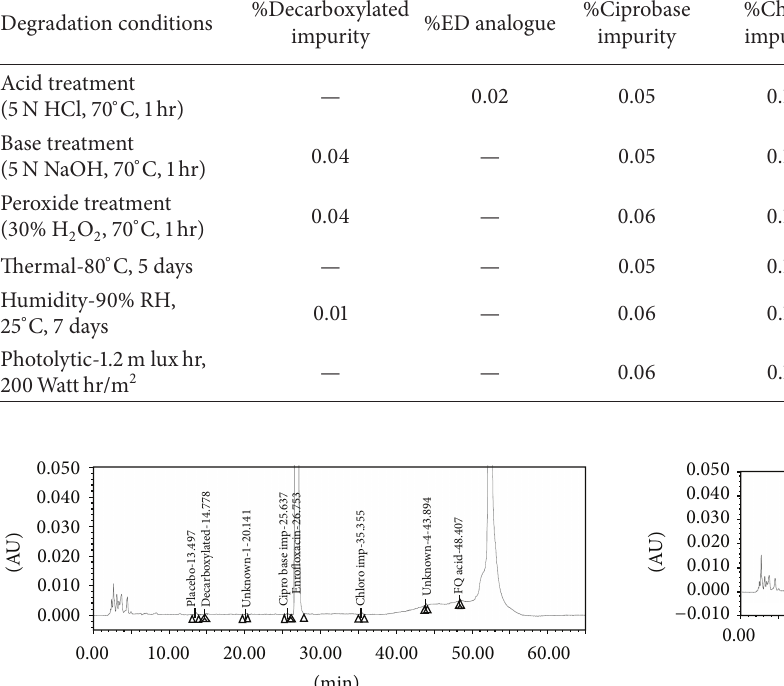
Figure 8: Control sample at 254 nm (concentration ∼ 0.5 mgmL −1 ).